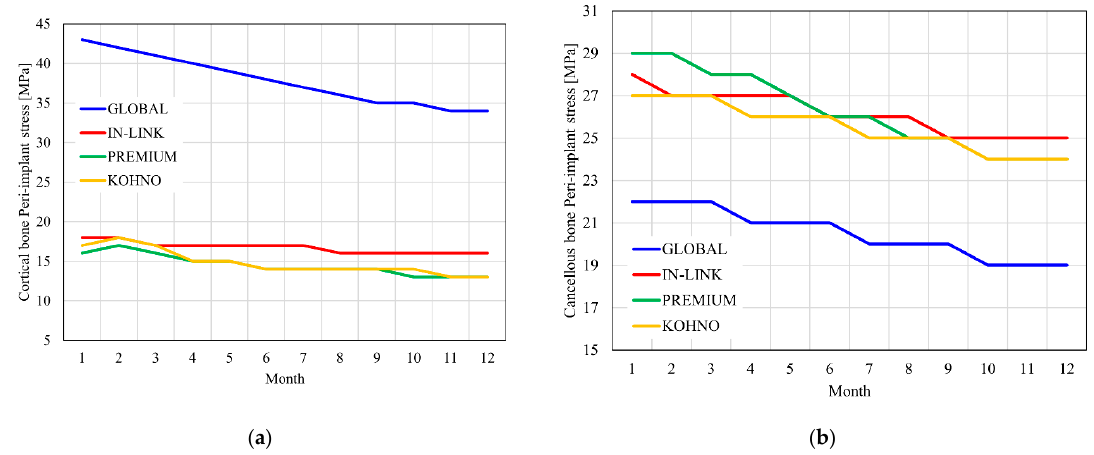
Figure 7. Average stress in: ( a ) crestal area; ( b ) peri-implant area.